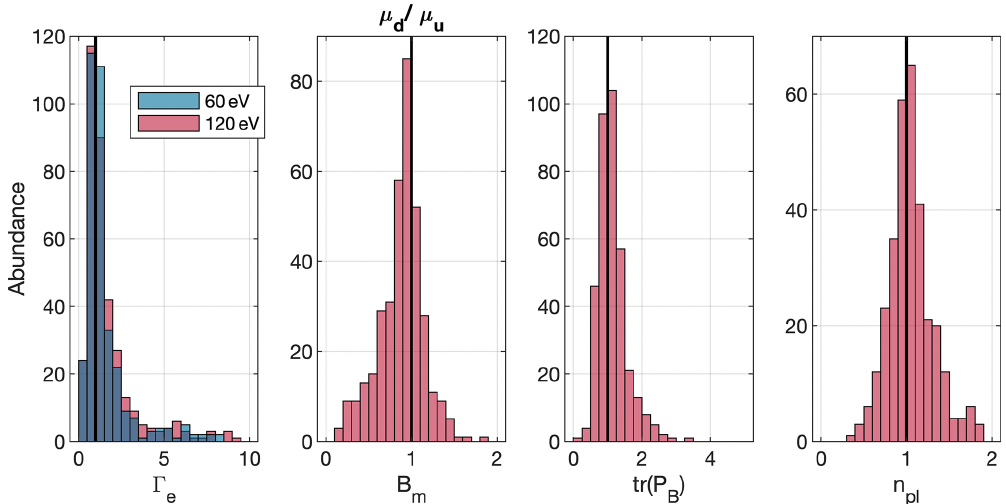
Figure 2. Comparison of the upstream and downstream mean values for four of the seven parameters chosen for investigation. From left to right: electron flux (cid:48) e at 60eV (blue) and at 120eV (red), magnetic field strength B m , trace of the magnetic field power spectral density tr (P B ) , and plasma density n pl